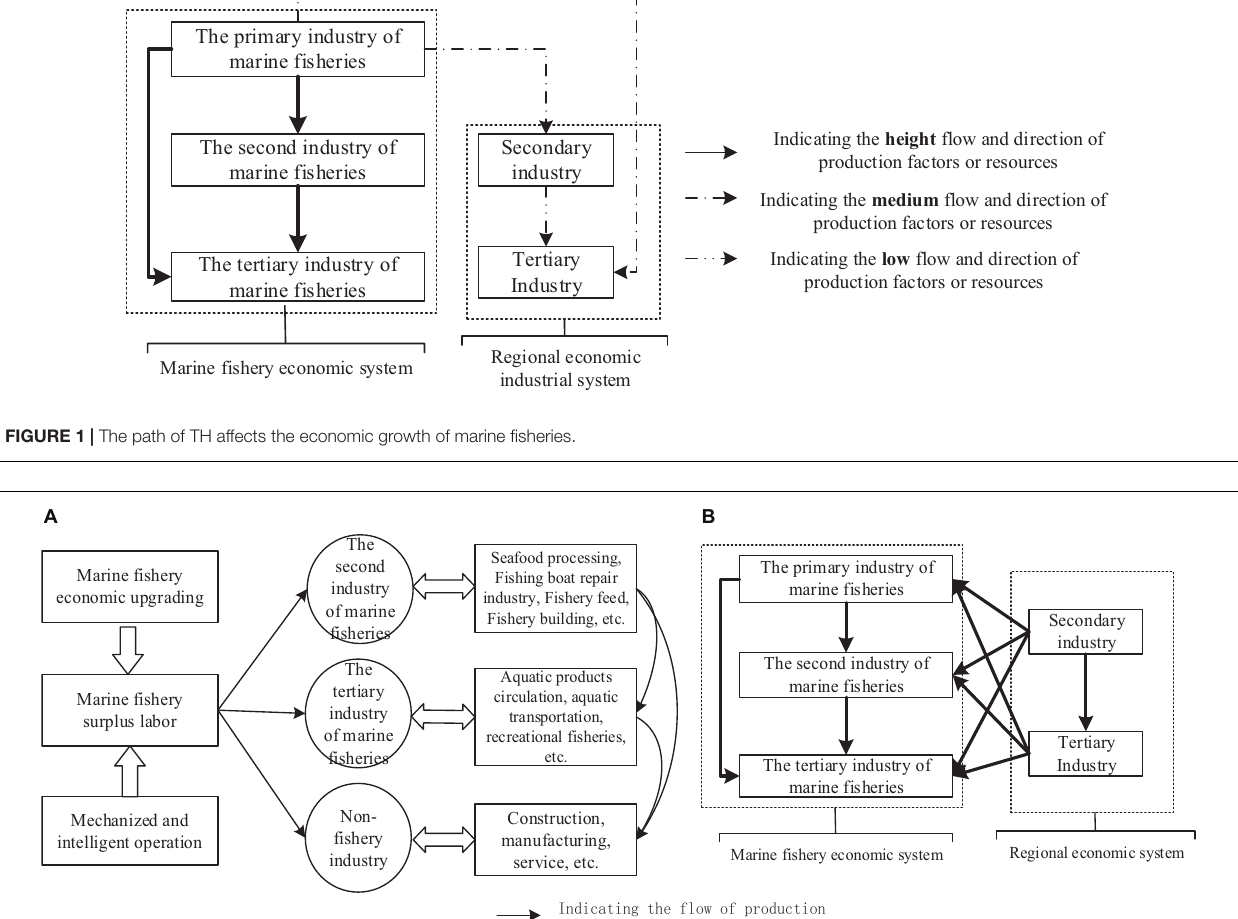
(cid:44)(cid:81)(cid:71)(cid:76)(cid:70)(cid:68)(cid:87)(cid:76)(cid:81)(cid:74) (cid:87)(cid:75)(cid:72)(cid:3)(cid:73)(cid:79)(cid:82)(cid:90)(cid:3)(cid:82)(cid:73)(cid:3)(cid:83)(cid:85)(cid:82)(cid:71)(cid:88)(cid:70)(cid:87)(cid:76)(cid:82)(cid:81)(cid:3) (cid:73)(cid:68)(cid:70)(cid:87)(cid:82)(cid:85)(cid:86)(cid:3)(cid:86)(cid:88)(cid:70)(cid:75)(cid:3)(cid:68)(cid:86)(cid:3)(cid:70)(cid:68)(cid:83)(cid:76)(cid:87)(cid:68)(cid:79)(cid:3)(cid:68)(cid:81)(cid:71)(cid:3)(cid:79)(cid:68)(cid:69)(cid:82)(cid:85)